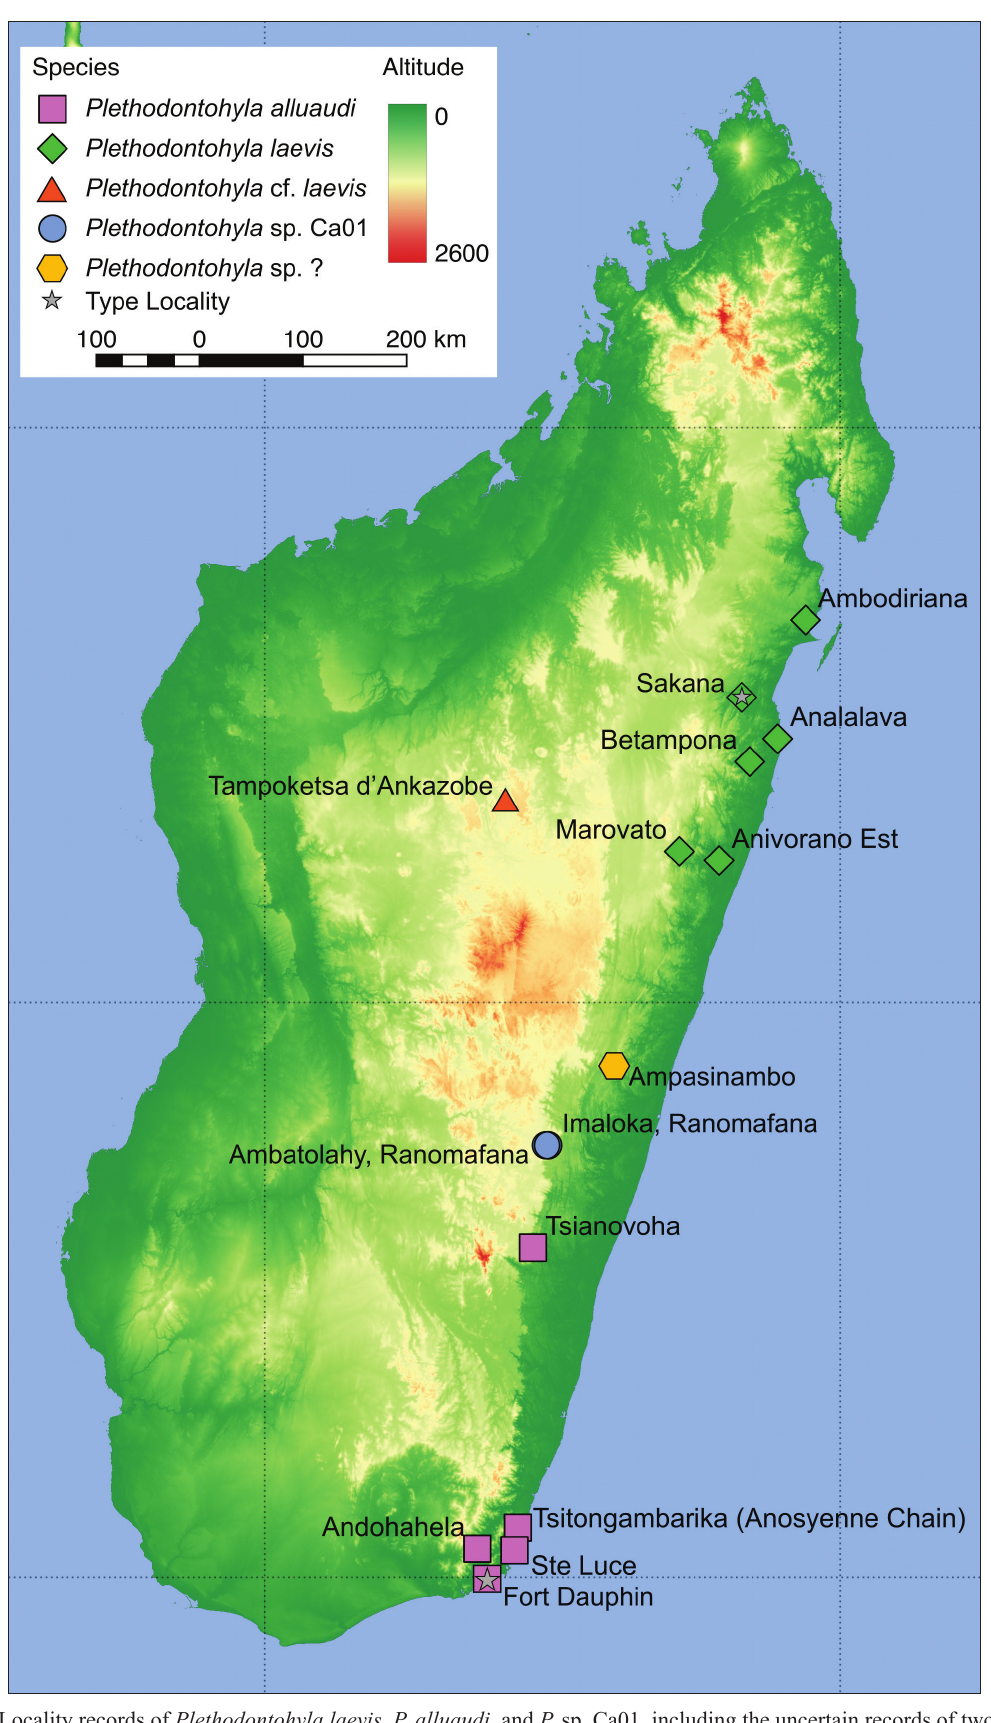
Figure 1. Locality records of Plethodontohyla laevis , P. alluaudi , and P. sp. Ca01, including the uncertain records of two members of this complex ( P. cf. laevis and P. sp.) from Blommers-Schlösser